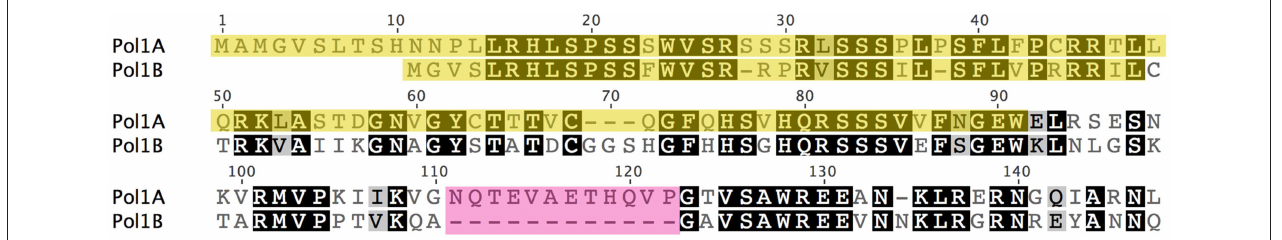
FIGURE 8 | Predicted signal peptides of PolIA and PolIB and sequence homology in the early region of each polymerase protein. Predictions of each protein’s signal peptide was made using ChloroP. Residues highlighted in yellow represent the predicted signal peptide to be cleaved after localization. Note that despite a much shorter predicted signal peptide, PolIB continues to maintain high homology with PolIA for ∼ 60 more residues. The first region of dissimilarity between the two polymerases is highlighted in